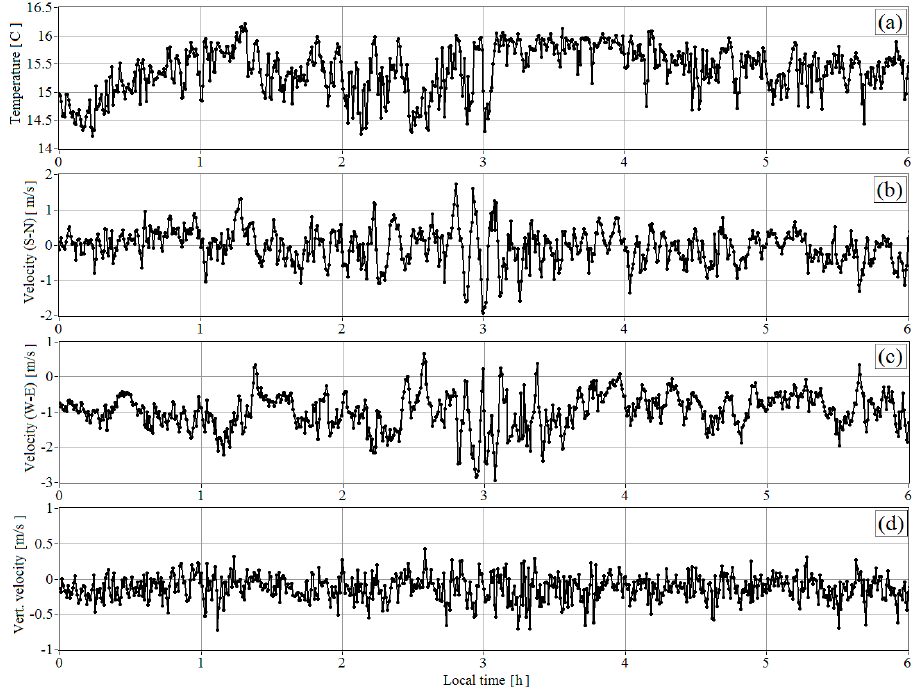
Figure 13. Time series of air temperature ( a ), horizontal component of the wind velocity from south to north ( b ), horizontal component of the wind velocity from west to east ( c ), and vertical wind velocity ( d ) obtained from the measurements by the sonic anemometer at a height of 10 m above the Baikal level on 23 August 2018 after the application of the procedure of low-frequency filtering with 30 s averaging.